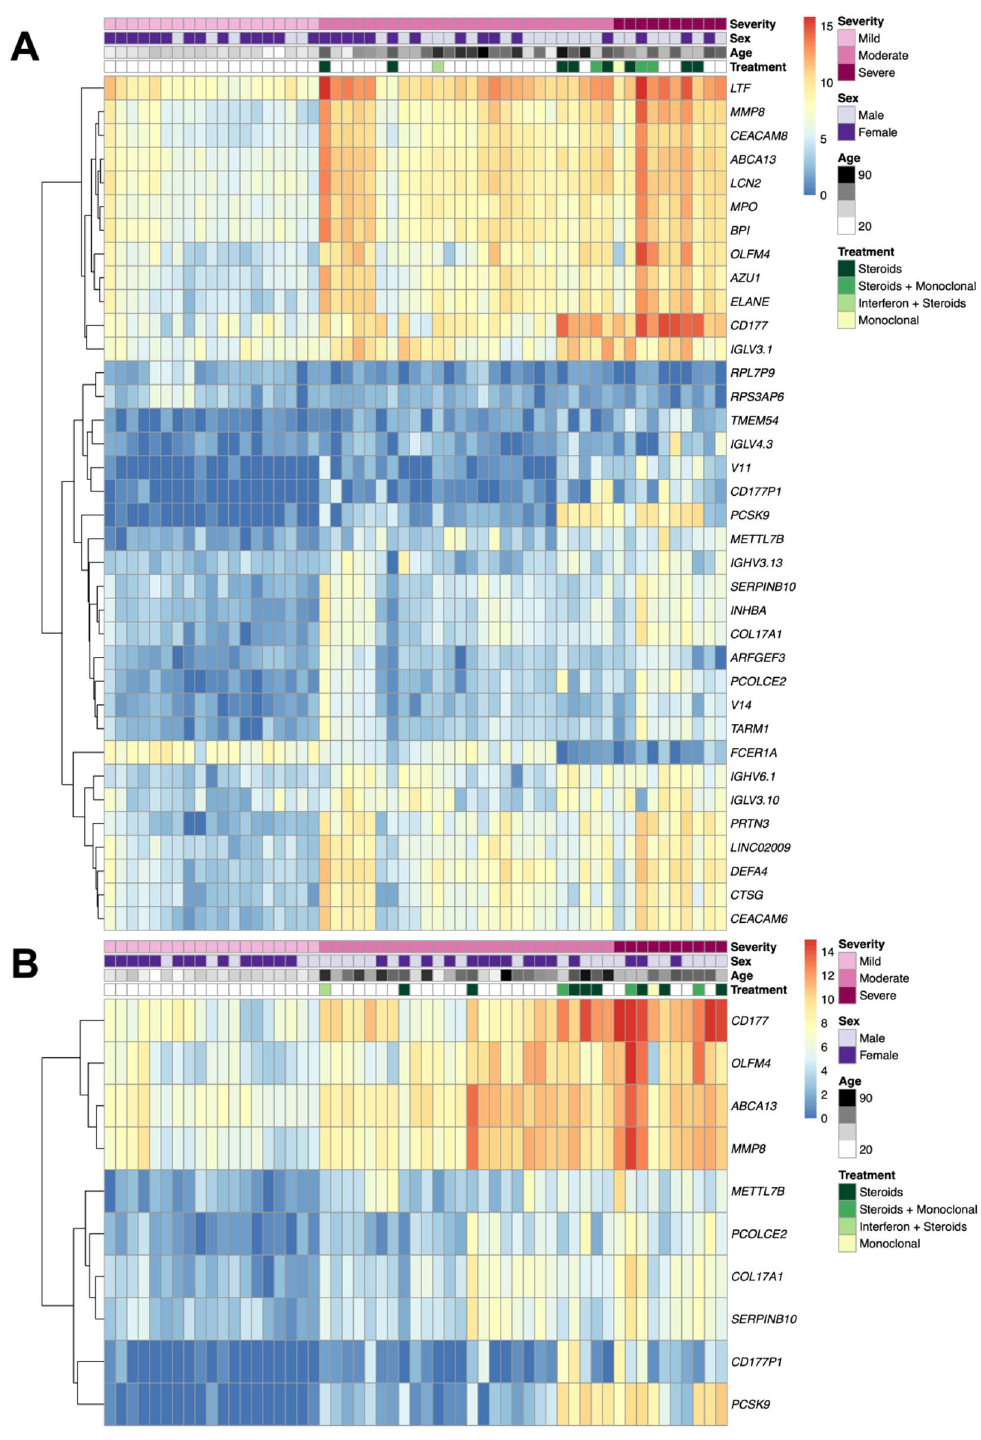
Figure 3. Heatmaps showing log-transformed expression values for ( A ) the 55 genes SDE with severity as an additive variable with absolute LFC values greater than 2 and B-H p -values < 0.0001 ( B ) the 10 genes SDE in all three pairwise severity comparisons in addition to the additive severity model with absolute LFC values greater than 2 and B-H p -values < 0.0001. Samples are ordered according to severity group. Age and sex were included as covariates in all differential expression analysis